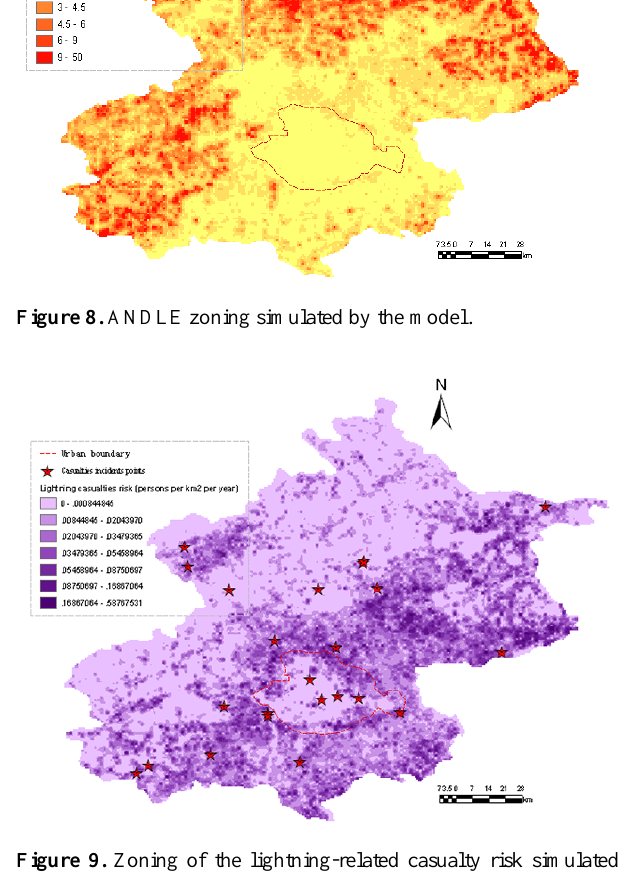
Figure 9. Zoning of the lightning-related casualty risk simulated by the model and the distribution of historical casualty incidents in Beijing.